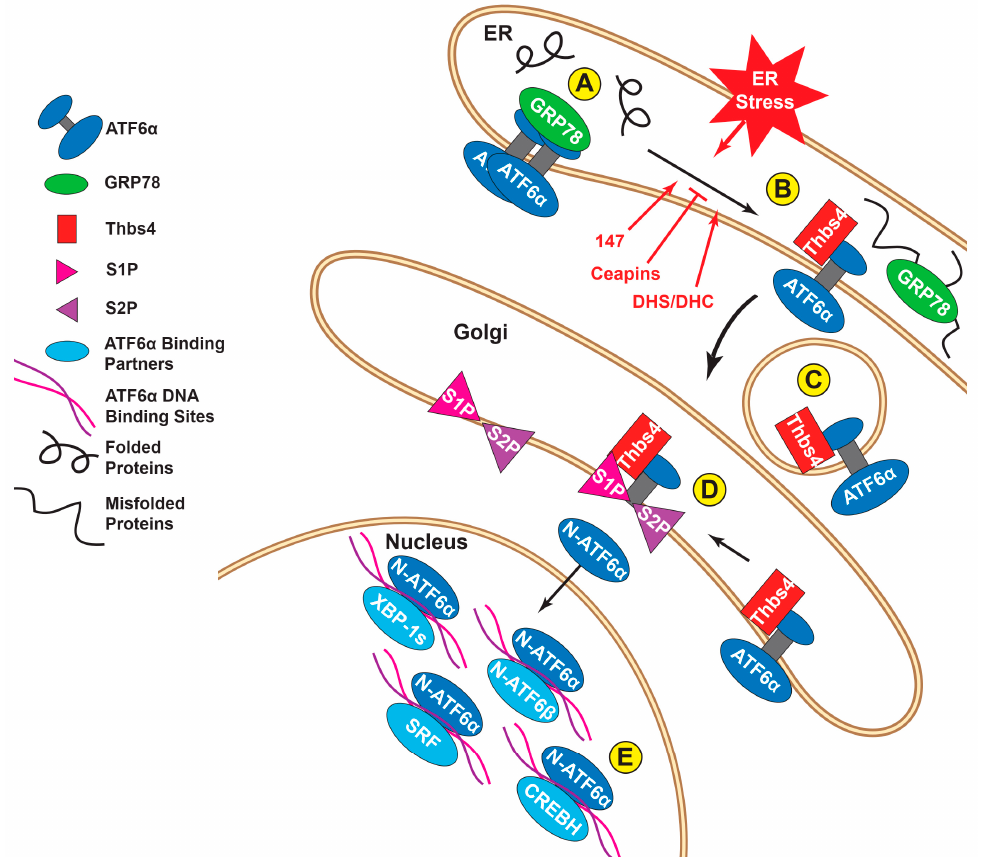
Figure 2. Focus on ATF6 α activation. ( A ) In the absence of ER stress, ATF6 α exists in an oligomeric state and its luminal domain associates with GRP78; ( B ) During ER stress, GRP78 relocates from ATF6 α to misfolded proteins; ATF6 α is then reduced to a monomeric state. Chemicals, such as compound 147, or certain sphingolipids, can promote ATF6 α relocation out of the ER in the absence of overt ER stress. Other chemicals, called Ceapins, inhibit this process, even during ER stress; ( C ) ATF6 α and binding partners, such as Thbs4, are packaged into COPII vesicles and transit to the Golgi; ( D ) Golgi resident proteases, S1P and S2P, cleave the N-terminal cytosolic region of ATF6 α from the transmembrane domain. The soluble N-terminal fragment (N-ATF6 α ) is then free to enter the nucleus where it binds to target genes and influences transcription; ( E ) N-ATF6 α binds DNA as a homodimer but is also known to form heterodimers with a number of other nuclear proteins, including N-ATF6 β , XBP-1s, SRF, and CREBH. Binding di ff erent partners can alter which transcripts N-ATF6 α